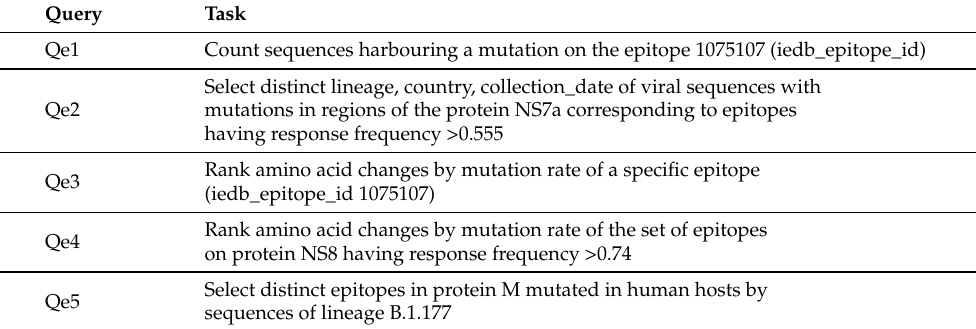
Table 4. The five test queries used for measuring the performance increase given by the offline pre-computation of the sequences mutating epitope regions. All the queries are relative to SARS-CoV- 2 viral samples collected from